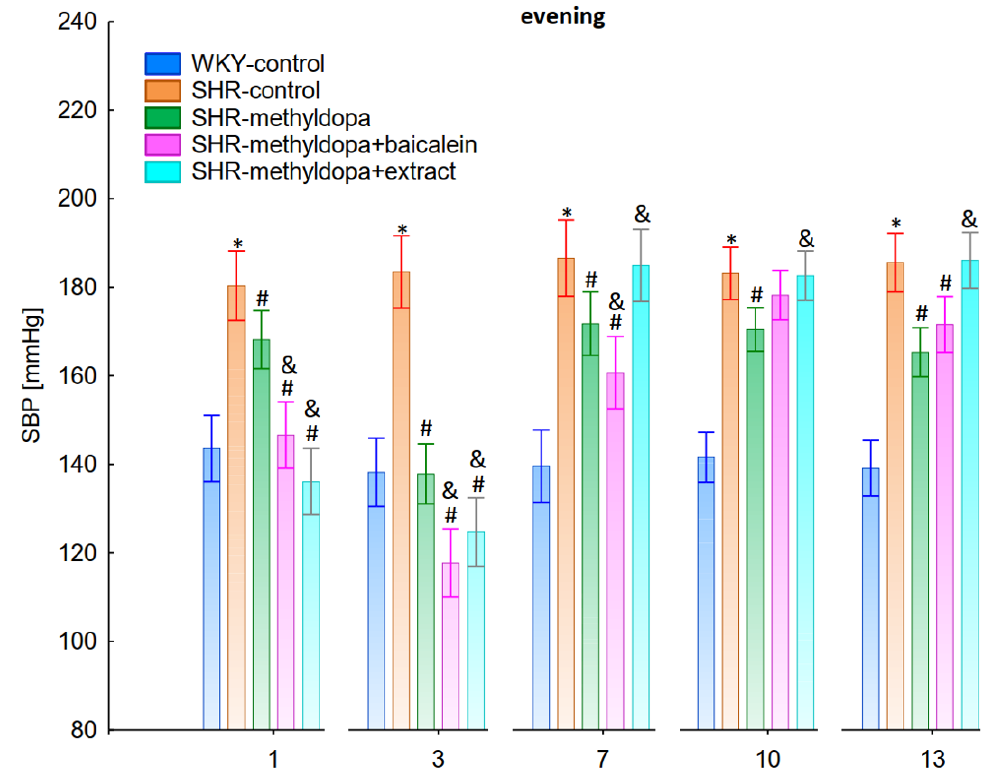
Figure 7. Influence of methyldopa and its combination with baicalein or extract from Scutellaria baicalensis roots on evening systolic blood pressure (SBP) in SHR pregnant rats. Legend: n = 10, mean ± SEM; *—vs. WKY control, p < 0.05; #—vs. SHR control, p < 0.05; &—vs. SHR-methyldopa, p <